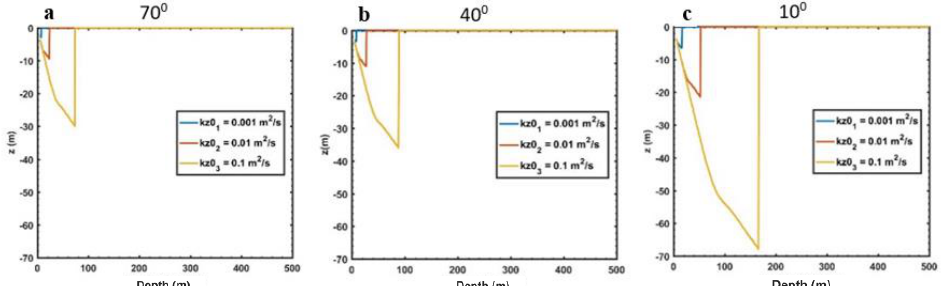
Figure 8. Sensitivity analysis for the depth at which the maximum velocity vector is found in the water column for tropical (10 ◦ ), medium (40 ◦ ), and high (70 ◦ ) latitudes. The columns of water at different depths are represented on the x -axis. The depth of maximum velocity resulting from the vectors u and v is represented on the y -axis. Sensitivity results for latitude 70 ◦ ( a ), 40 ◦ ( b ), and 10 ◦ ( c ).